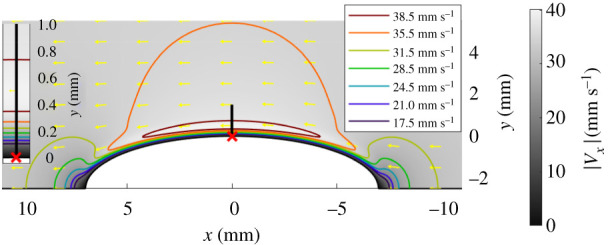
Cross-section of fluid flow over a prolate spheroid of approximate bumblebee dimensions obtained by finite-element modelling. The flow shown is driven by an oscillating free field air flow V0 in the x direction, |V0| = 35 mm s−1, f = 130 Hz. The greyscale colour gradient shows flow speed in the x direction |Vx| at a snap-shot in time. Yellow arrows depict the direction of flow and coloured isolines show zones of equal fluid velocities. The red cross is the position of the base of the hair and the black line shows a 1.5 mm hair extending perpendicular to the body surface. (Inset) Close-up view of the boundary layer demonstrating the low flow velocity near the surface (1 mm depth) which increases with distance y from the surface.